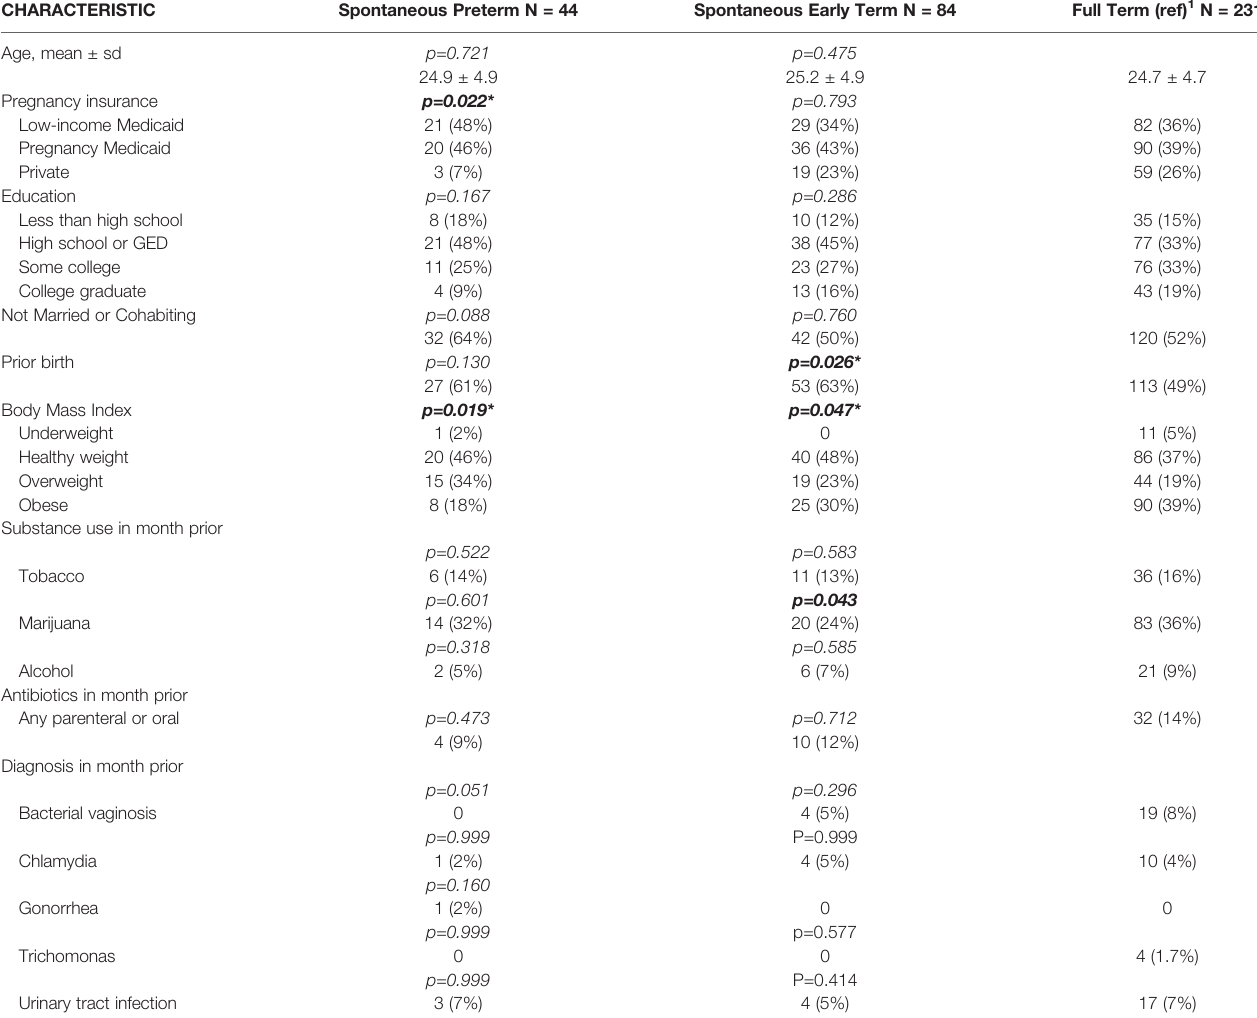
1 p-value indicates the result of the Chi-square test of signi fi cance with full term births as referent category; bold indicates statistical signi fi cance for a = 0.05.